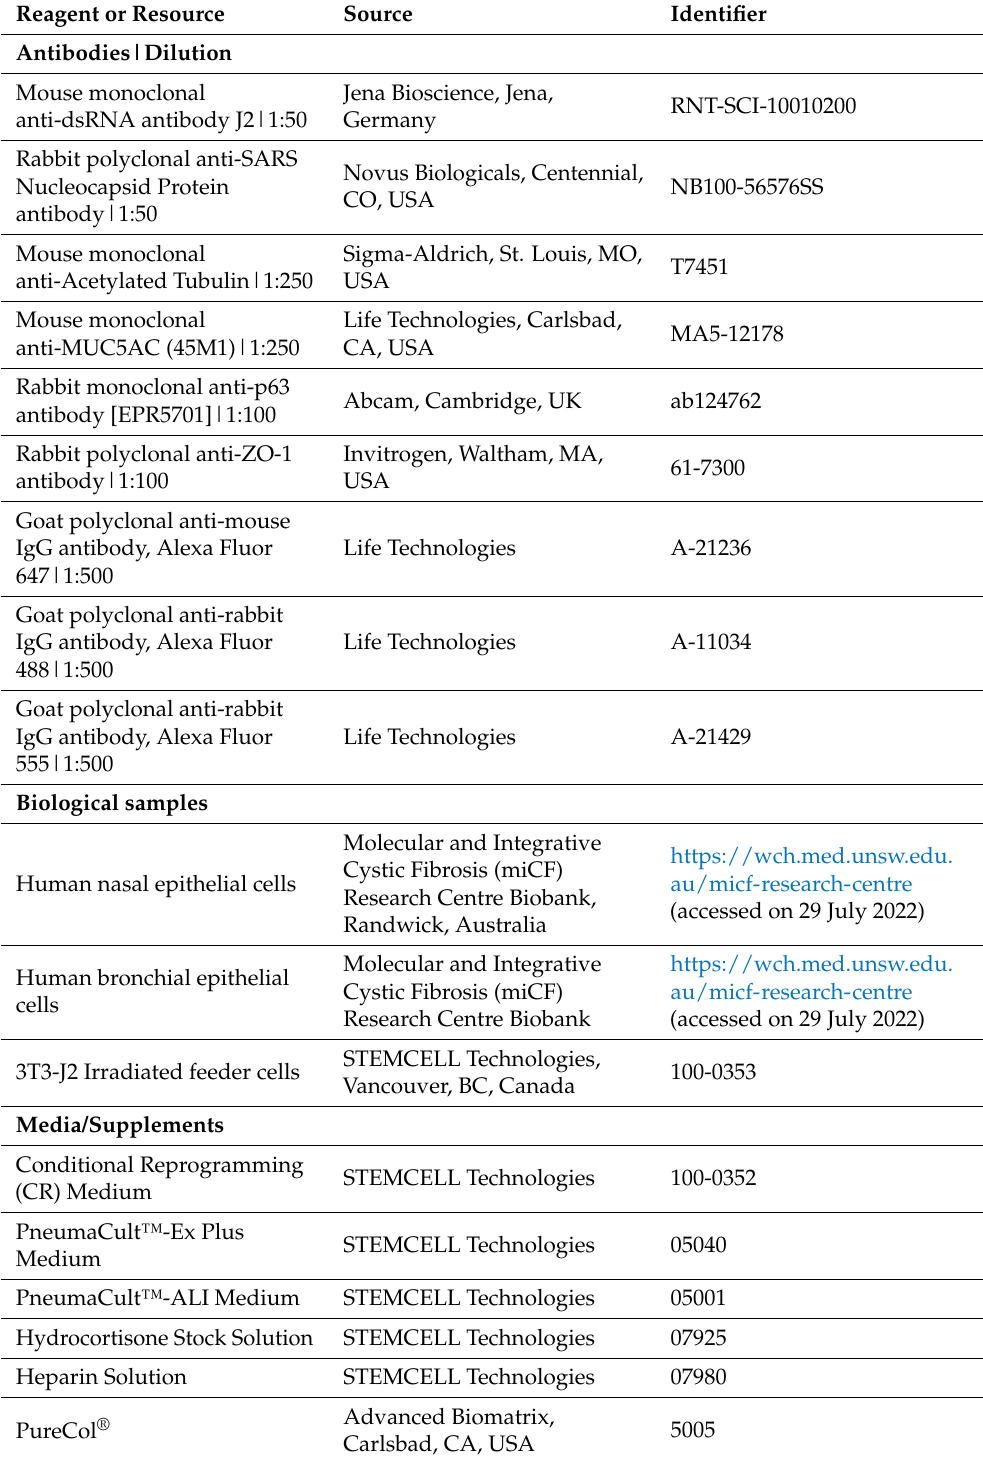
Table 1. Key resources used in the